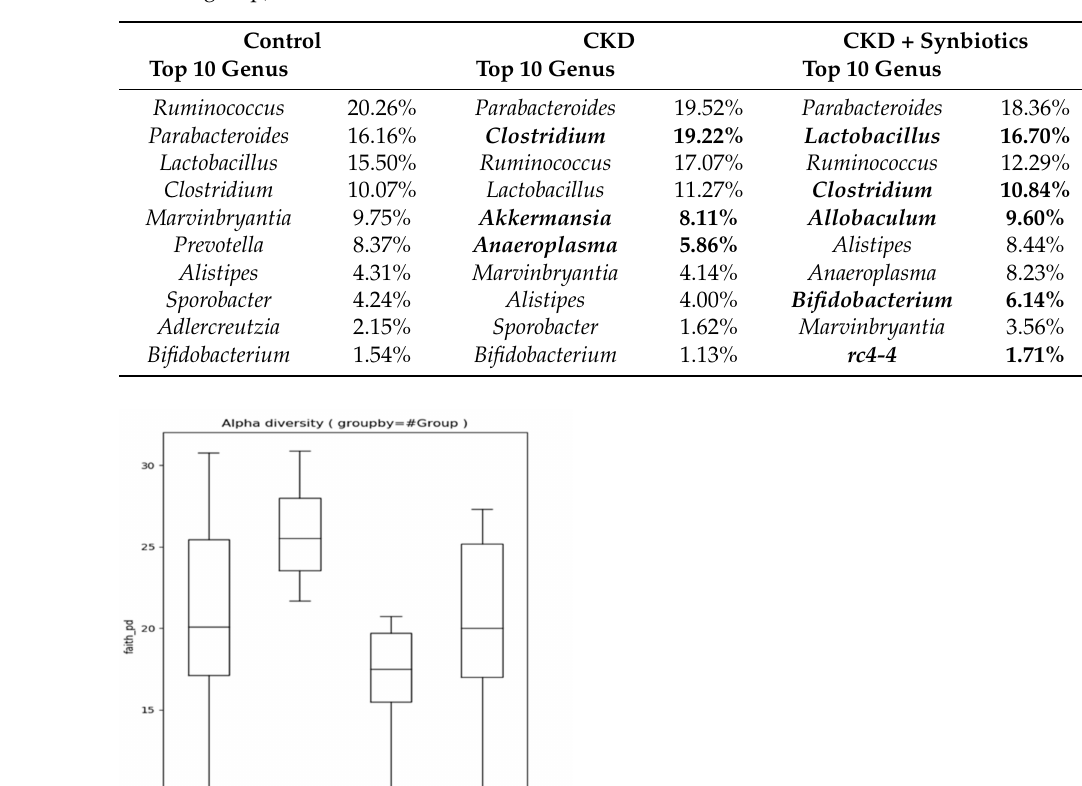
Table 5. Composition of gut microbiota of controls, CKD rats, and synbiotics-treated CKD rats ( n = 6 for each group).